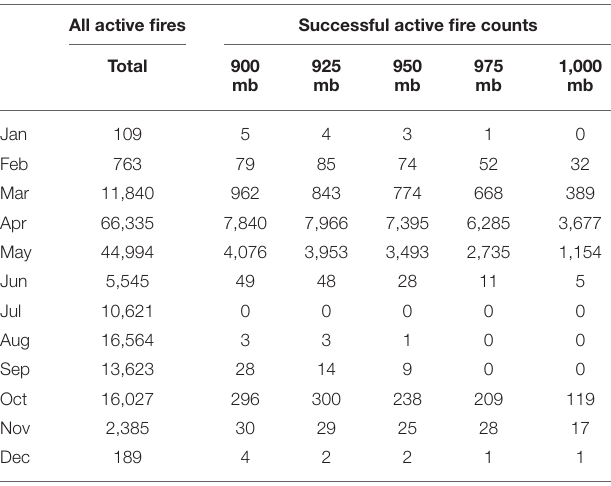
TABLE 1 | Monthly average (2003–2015) successfully transported and total active fire counts within the Russian croplands. All active